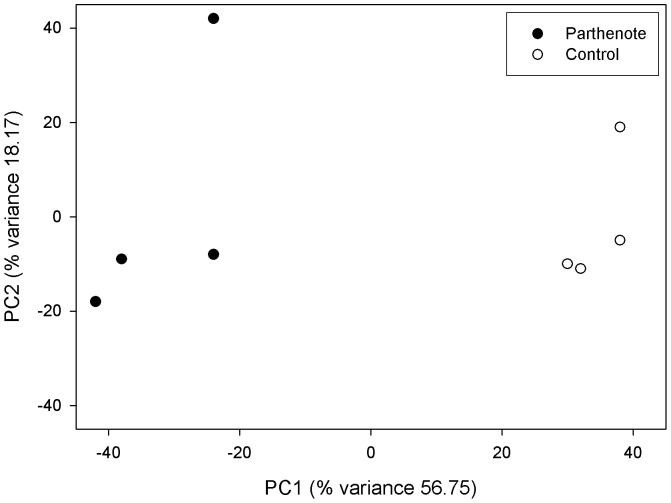
Principal Component Analysis (PCA) of microarray data. PCA two-dimensional scatter plot represent the differential gene expression patterns of frozen and control embryos. Axis: X = PC1: PCA Component 1 (56.75% variance); Y = PC2: PCA Component 2 (18.17% variance).